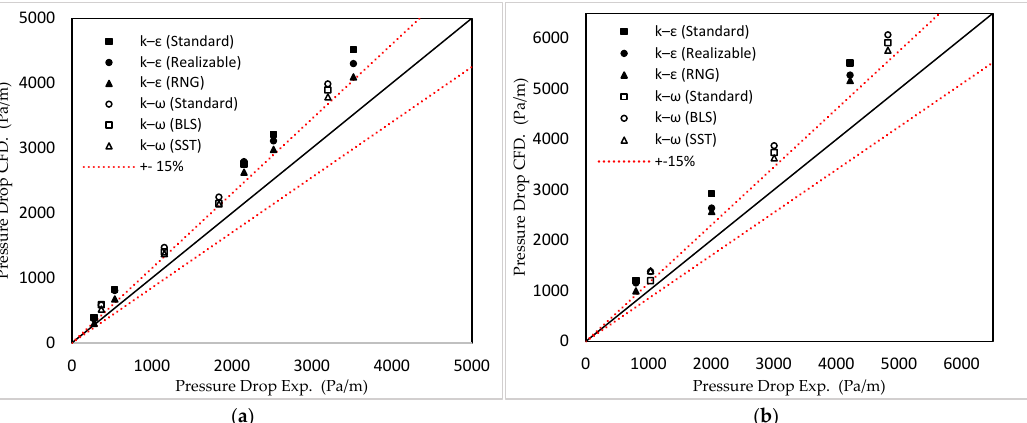
Figure 14. Comparison of frictional pressure drop obtained from CFD model vs. experimental data for Herschel–Bulkley fl uids. ( a ) BXG2 fl uid in pipe diameter 19.1 mm. ( b ) BXG4 fl uid in pipe diam- eter 76.2 mm.